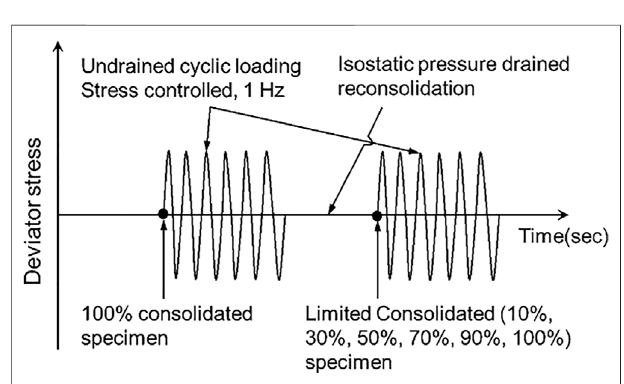
FIGURE 5 | Loading scheme for the dynamic characteristic test of lique fi ed